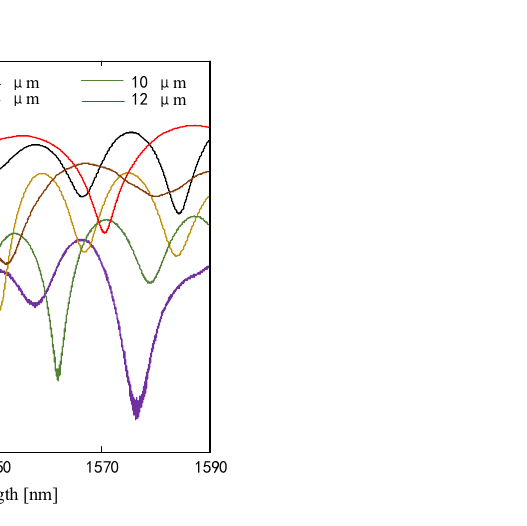
Figure 3. Interference spectra of the MI samples with length of 2 cm and core offsets of 1, 2, 4, 8, 10 and 12